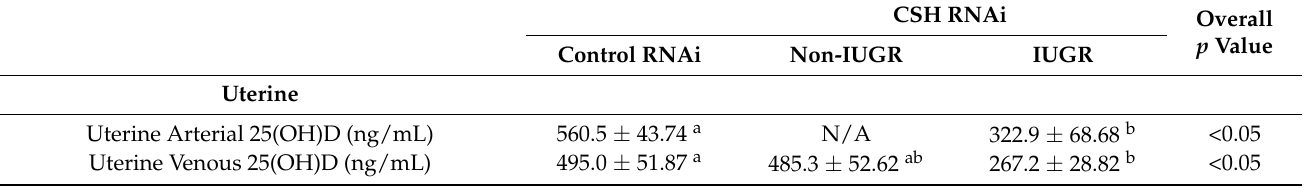
Table 2. Effect of CSH RNAi on serum 25(OH)D abundance. Data are presented as means ± SEM. Different superscripts indicate statistical significance. (Control RNAi n = 4–10; CSH RNAi Non-IUGR n = 6; CSH RNAi IUGR n = 4). CSH, chorionic somatomammotropin; IUGR, intrauterine growth restriction; N/A, samples/results not available; RNAi, RNA